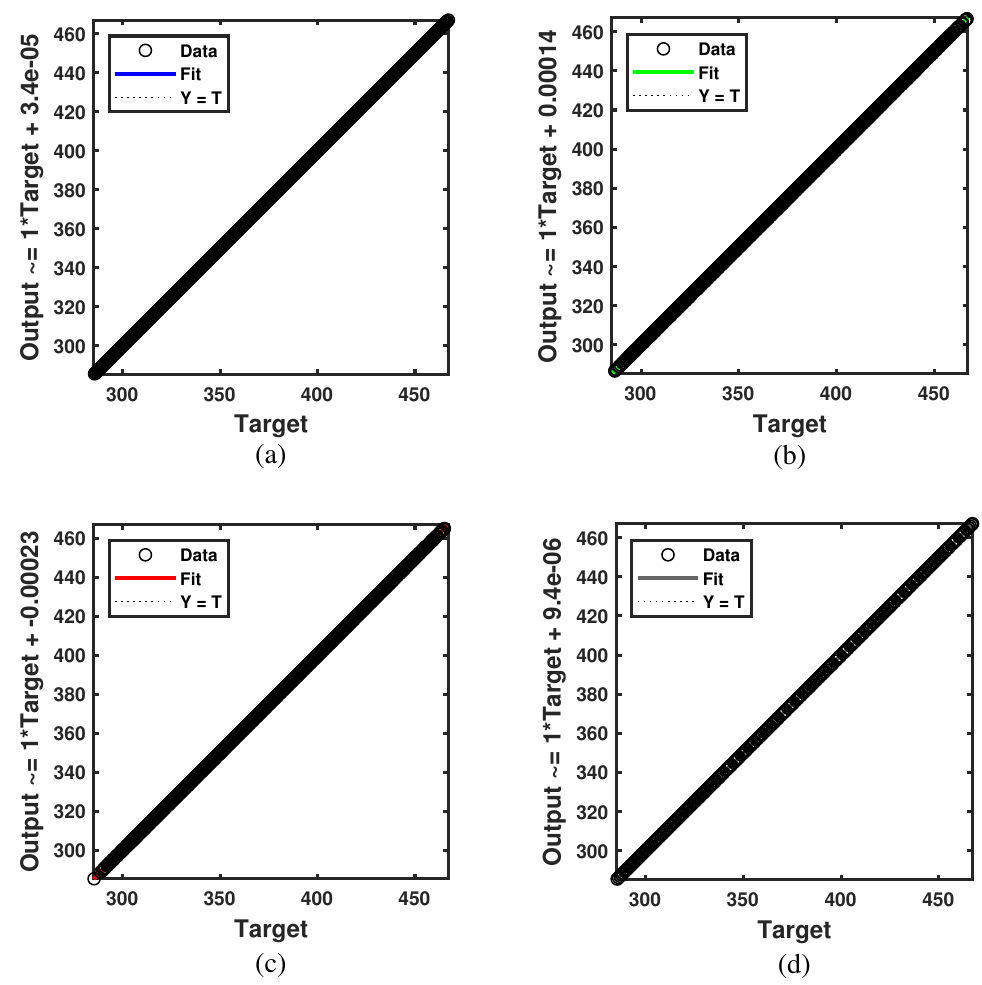
Figure 9. Regression graph ( a ) Training R = 1; ( b ) Validation R = 1; ( c ) Test R = 1; ( d ) All R =